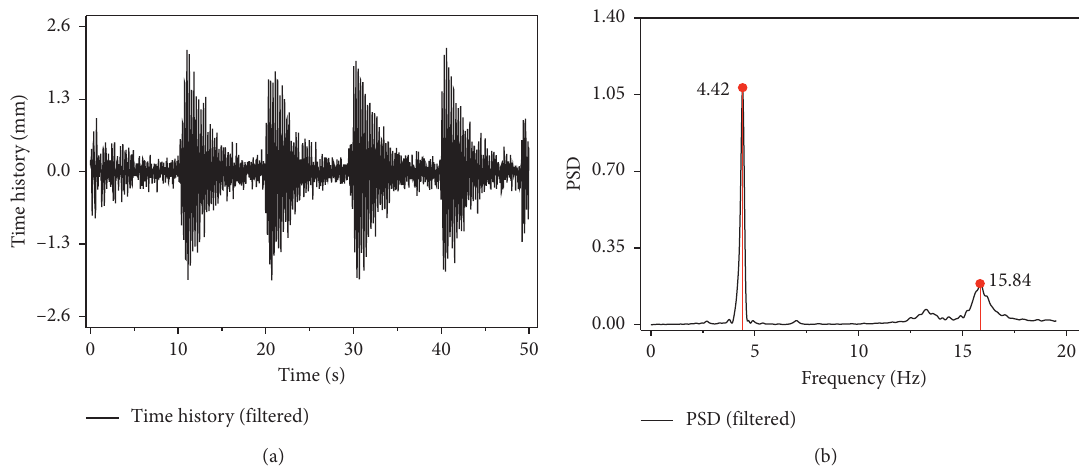
Figure 9: (a) Time-history curve and (b) PSD curves at the ending point after filtering.